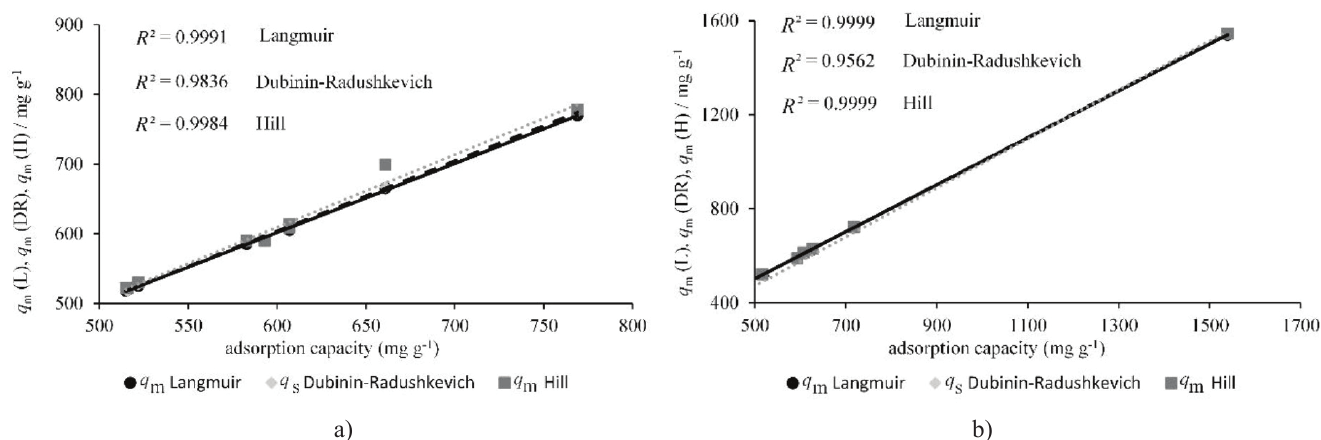
Fig. 5 – Correlation between adsorption parameters (q tion capacities (q ) obtained experimentally a) at different temperatures; b) at different pH values (adsorption capacities obtained in e the experiment with the initial concentration of 150 mg L –1 in the reaction